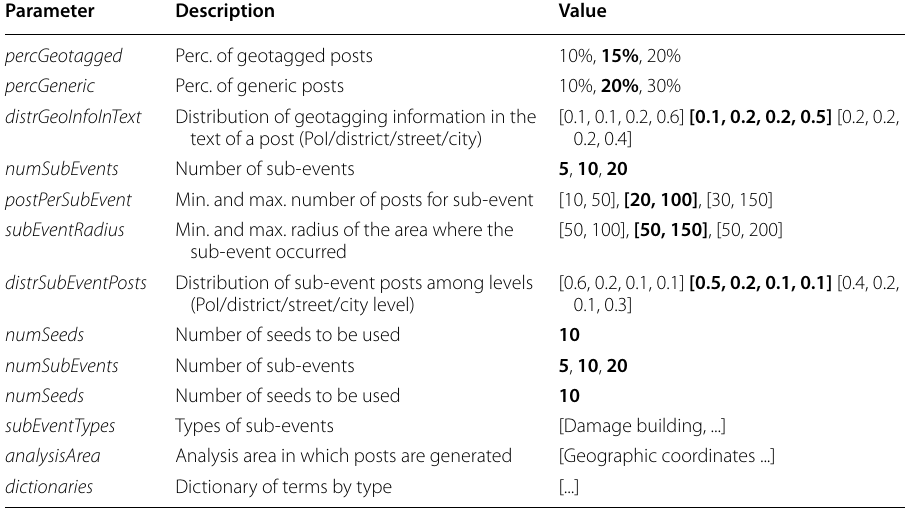
Table 4 Simulation